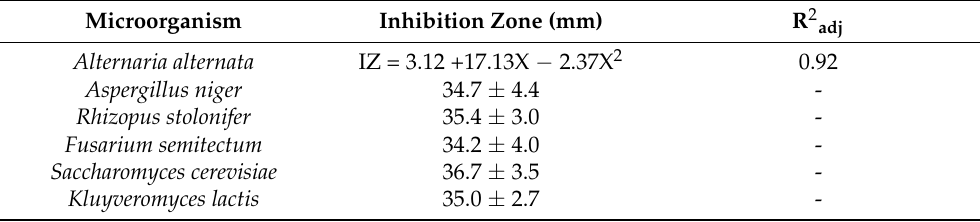
IZ = inhibition zone; X = natamycin concentration (wt./wt.).